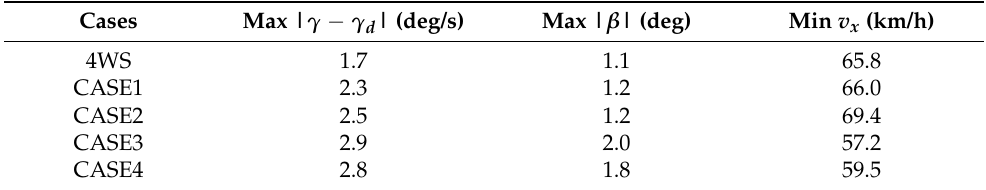
Table 2. Comparison of results for each